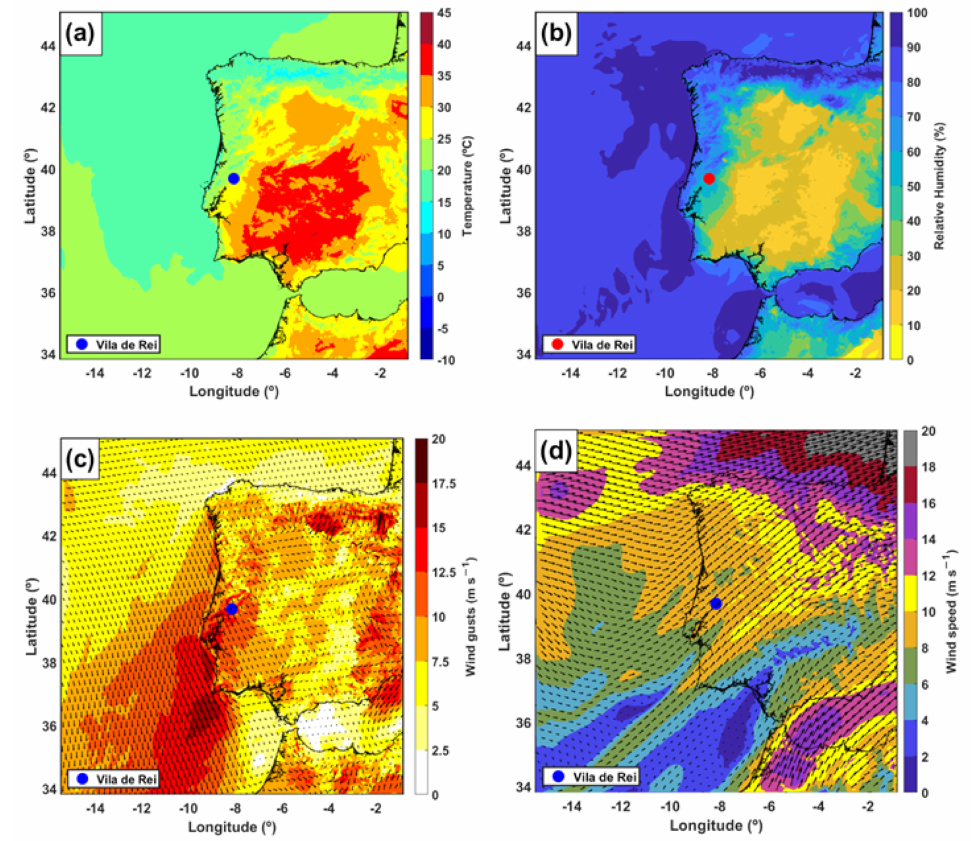
Figure 6. Fire weather conditions in the Iberian Peninsula at 1800 UTC on 20 July 2019 obtained from EXP results: ( a ) Air temperature at 2 m ( ◦ C); ( b ) relative humidity at 2 m; ( c ) wind gusts and wind direction (arrows) at 10 m; and ( d ) wind speed and direction (arrows) at 5000 m